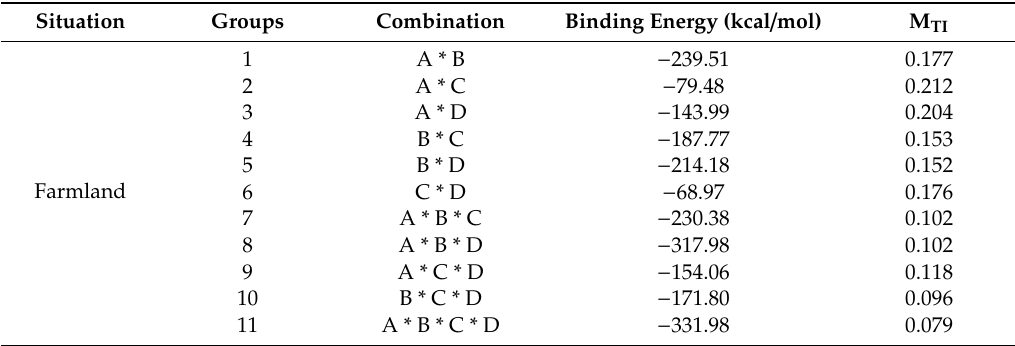
Table 10. Binding energy between QNs and ryegrass toxicity receptors (SOD and Pro) before and after modification. Situation